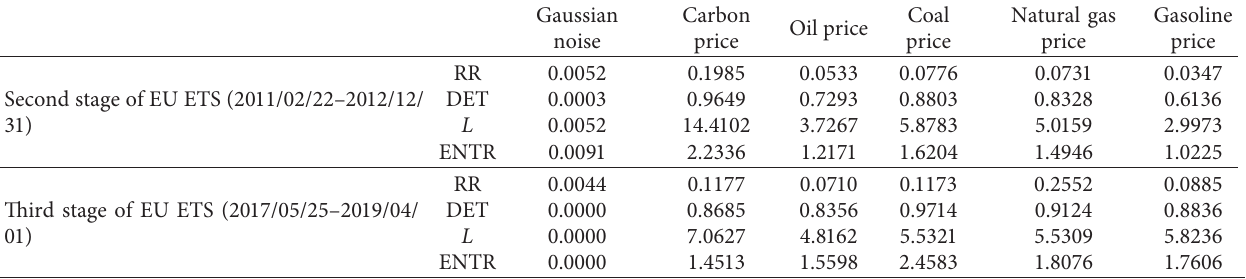
Table 2: RQA measures of the six series of Gaussian noise, carbon prices, and energy prices.